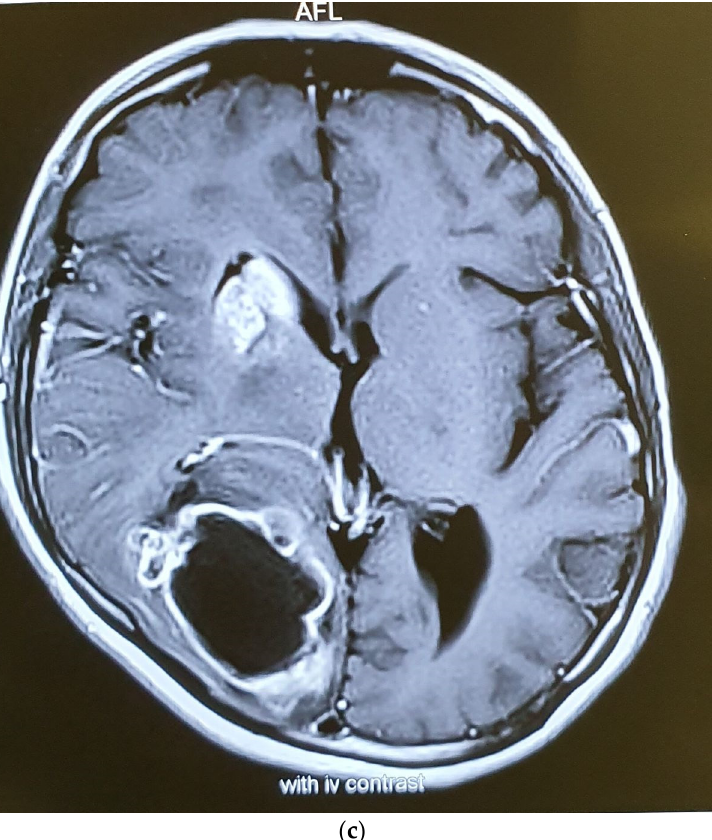
Figure 6. Axial T1W ( a ), T2W ( b ), and Gad-Enhanced MRI ( c ) showing the large cystic mass in the right parietooccipital area together with the old lesion in basal ganglia .